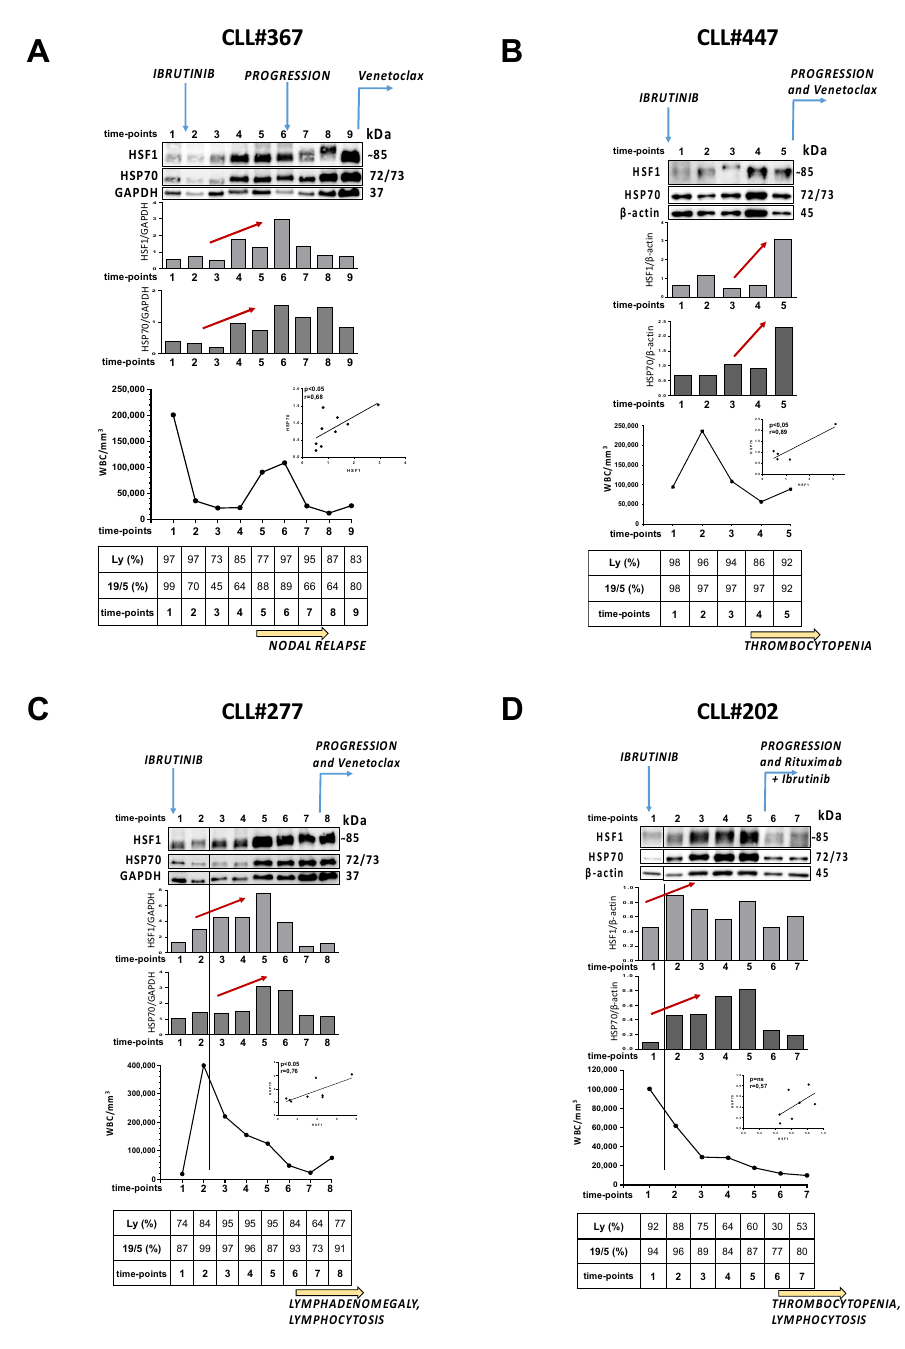
Figure 3. HSP70 and HSF1 expression levels remain elevated in patients who fail treatment with Ibrutinib. Data are related to patient #367 (( A ), time-points: 1 to 9), #447 (( B ), time-points: 1 to 5), #277 (( C ), time-points: 1 to 8), #202 (( D ), time-points: 1 to 7). From top to bottom: analysis of HSF1, HSP70 and GAPDH or β -actin by Western blotting; densitometric analysis of HSF1/GAPDH or β -actin and HSP70/GAPDH or β -actin ratios at the different time-points; patient’s white blood cell count; percentage of lymphocytes/total white blood cells; percentage of CD19 + /CD5 + lymphocytes/total number of lymphocytes. At the top of all sections, blue arrows indicate the start of treatment with ibrutinib, the start of progression and the start of another treatment (e.g., venetoclax, anti-Bcl2). At the bottom, yellow arrows indicate the onset of clinical disease progression (e.g., lymph node recurrence, thrombocytopenia, etc.). Inside the figure, red arrows indicate an increase in the expression of HSP70 and HSF1. Linear correlation graphs are related to HSP70 expression level vs. HSF1 expression levels at each time-point ( p < 0.05 for A, B and C; Pearson’s correlation). WBC: white blood cells.